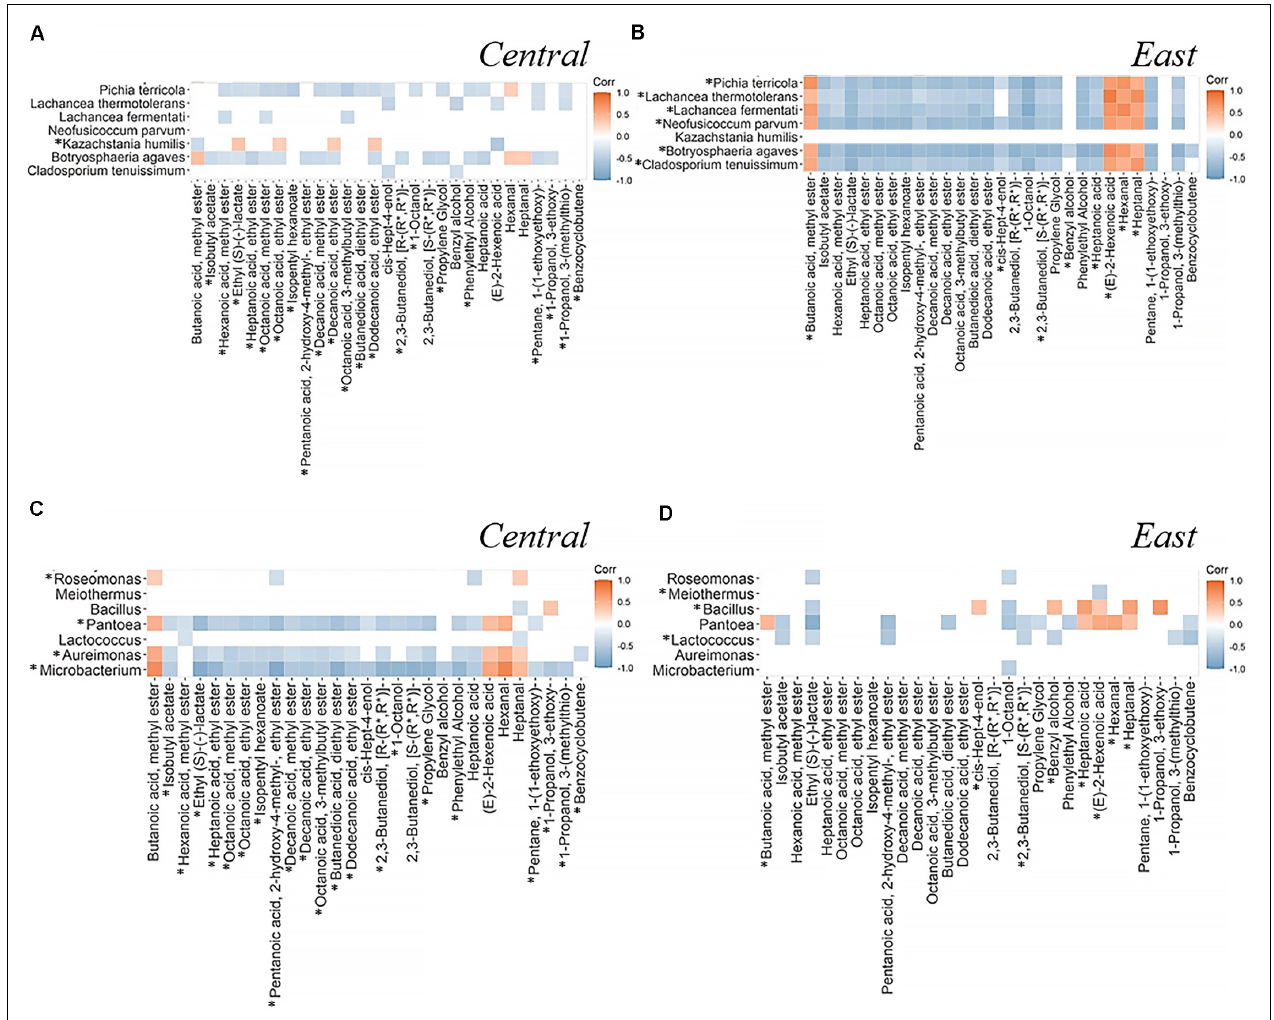
FIGURE 7 | Spearman’s correlation analysis between significantly different microorganisms identified by LEfSe and volatile metabolites identified by PLS-DA. Data shown here are the correlation coefficients between seven fungi (A,B) or seven bacteria (C,D) and 29 volatile metabolites across fermentation stages in the Central (A,C) and East (B,D) regions. Positive correlations on the heatmap are represented by orange and negative correlation are in gray. Spearman’s correlation significance indicated by coefficient with q -value < 0.05 (coefficients with q > 0.05 are shown in white block). The comprehensive correlation heatmaps of microbial communities and volatile metabolites are provided in the Supplementary Figure 4 . *highlighted the features with higher abundance for the indicated